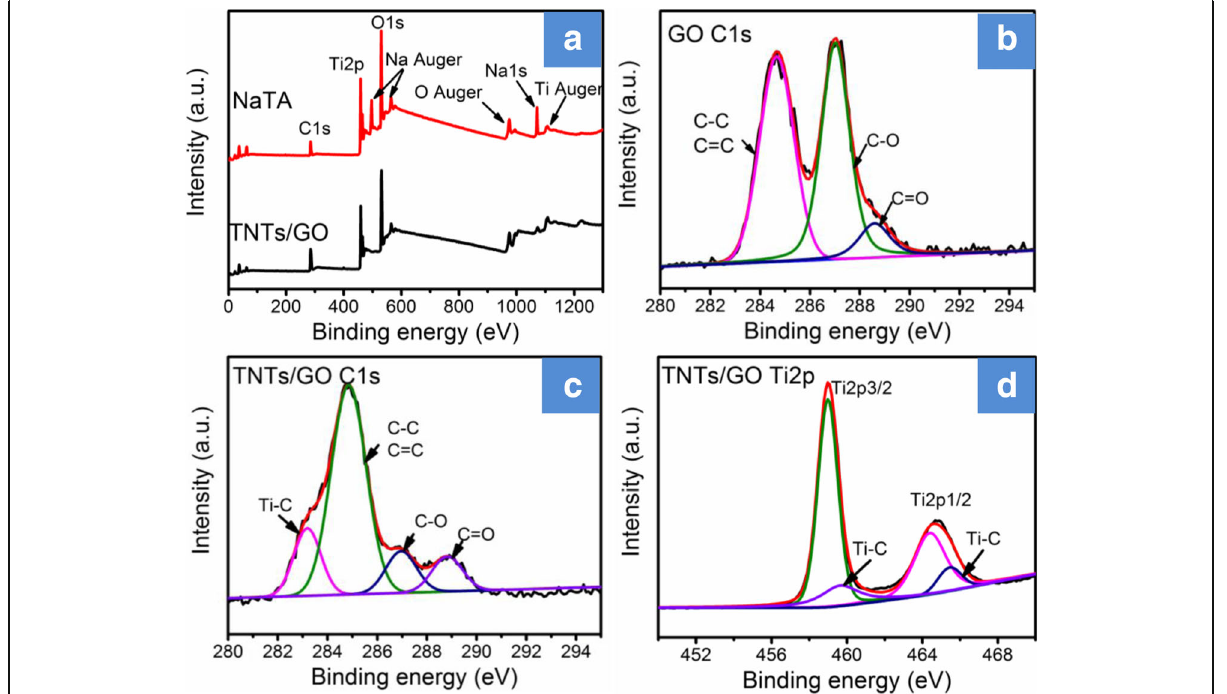
Fig. 3 a – d XPS spectra of GO and TNTs/GO nanocomposites. Ti – C bonds are formed between GO and TNTs to provide TNTs/GO nanocomposite through a stable chemical attachment rather than a physical absorption